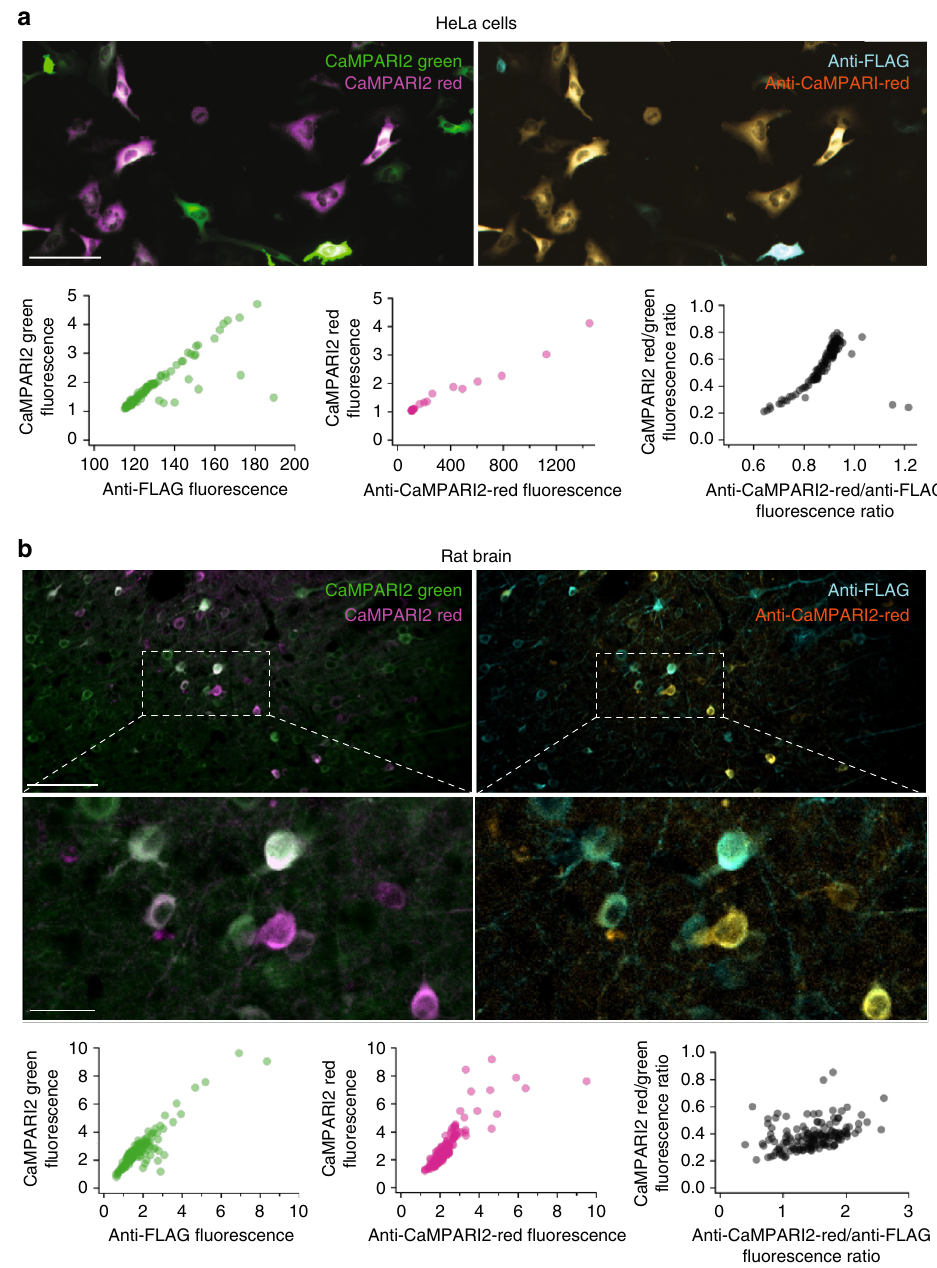
Fig. 6 Comparison between endogenous fl uorescence and anti-CaMPARI-red antibody stain. HeLa cells ( a ) and rat brain ( b ) were immunostained with anti-CaMPARI2-red and anti-FLAG antibody as described in Supplementary Methods. Plots of endogenous fl uorescence vs. the antibody signal show a linear relationship (green and magenta scatterplots). The black scatterplots show the correlation between the endogenous red-to-green ratio and the anti- CaMPARI-red-to-anti-FLAG ratio. Scale bars are 100 or 25 µ m